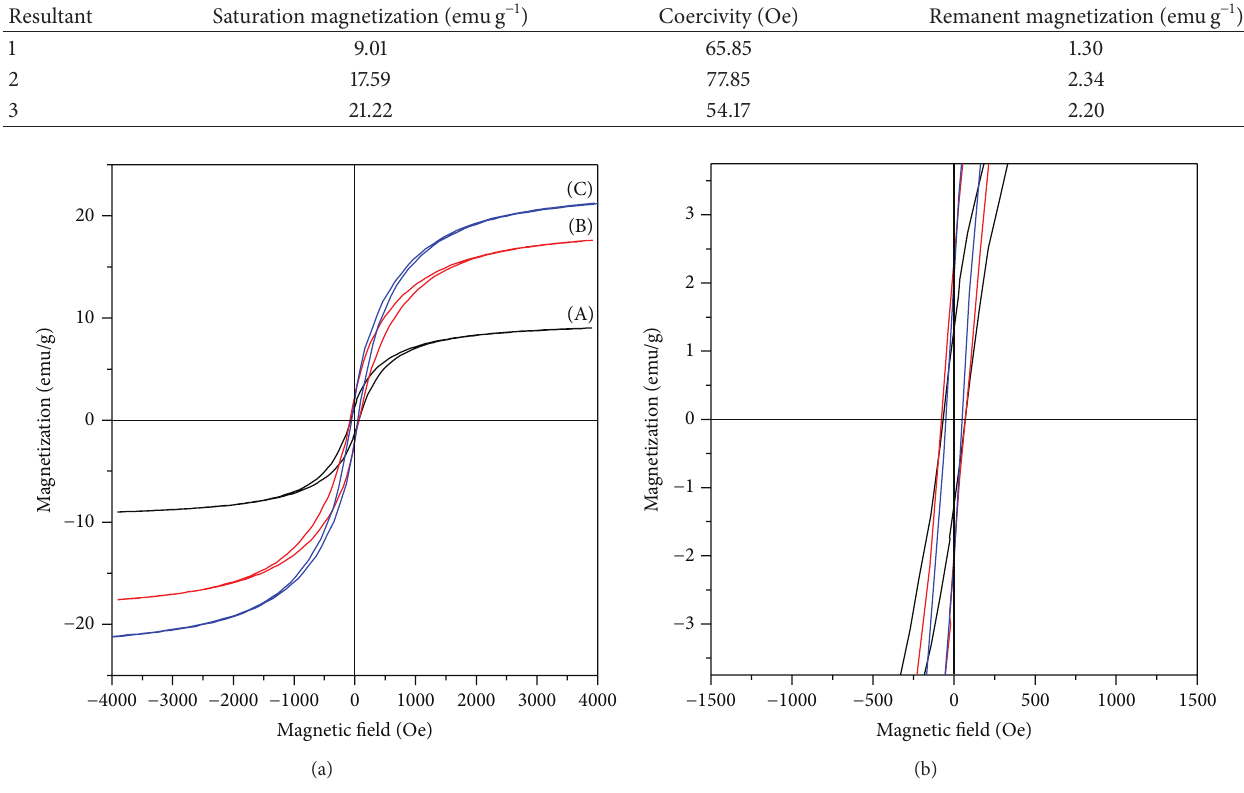
Figure 4: Complete magnetic hysteresis curve (a) and partial of this curve showing the coercive force (b) of the Fe-Ni-Pb-B alloy nanoparticles: (A) resultant 1 , (B) resultant 2 , and (C) resultant 3